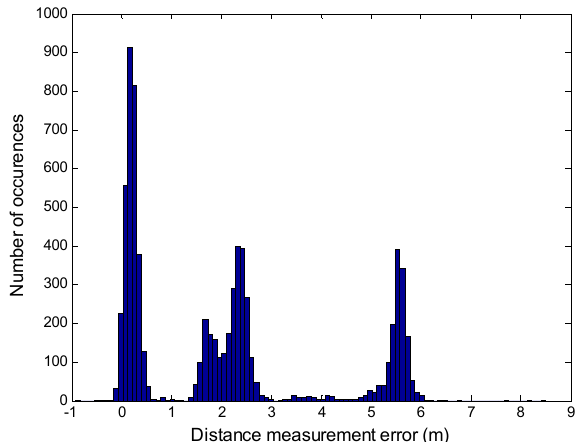
Figure 1. Example of an error distribution of real distance measurements realized in an indoor environment